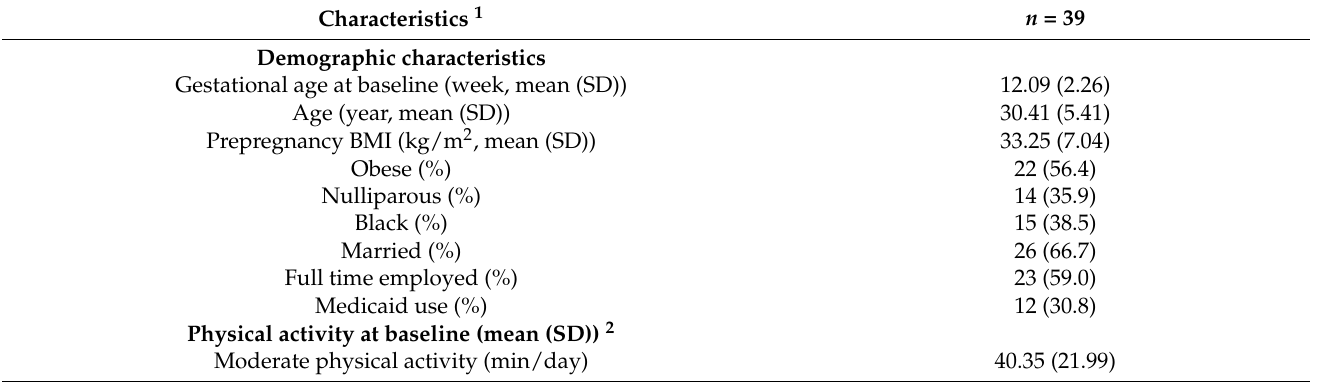
Table 1. Maternal demographic characteristics for the 39 pregnant women at baseline (around 12 weeks of